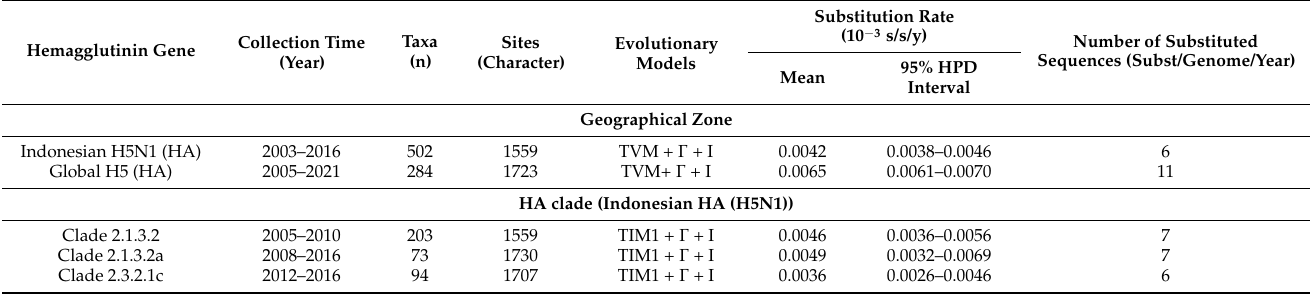
Table 1. The substitution rates of Indonesian HPAIv A(H5N1) 2003–2016 and representative world- wide HA of H5N1v with the estimation of root